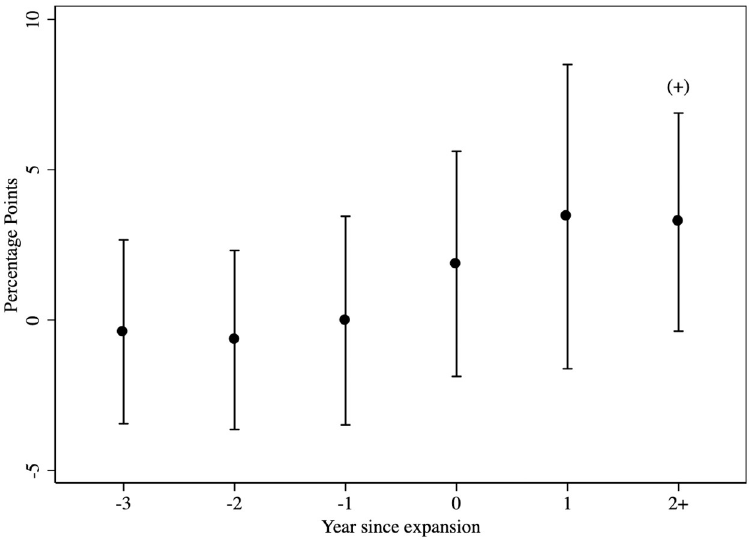
Fig 1. An event study test of the parallel trends assumption. +p < 0.10 Differences in SNAP participation shown for Medicaid expansion status versus non-expansion states, relative to expansion year. Ninety-five-percent confidence intervals shown. Data source is the Current Population Survey ASEC, 2011–2020 (reporting periods